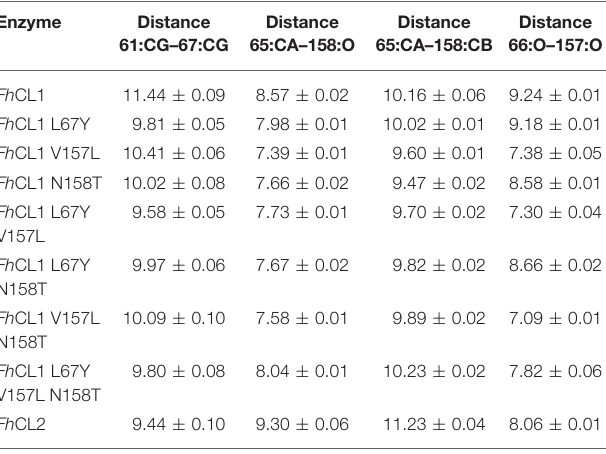
TABLE 3 | Interatomic distances measured as shown in Figure 5 between selected residues in the S 2 and S 3 sites in MD simulations.